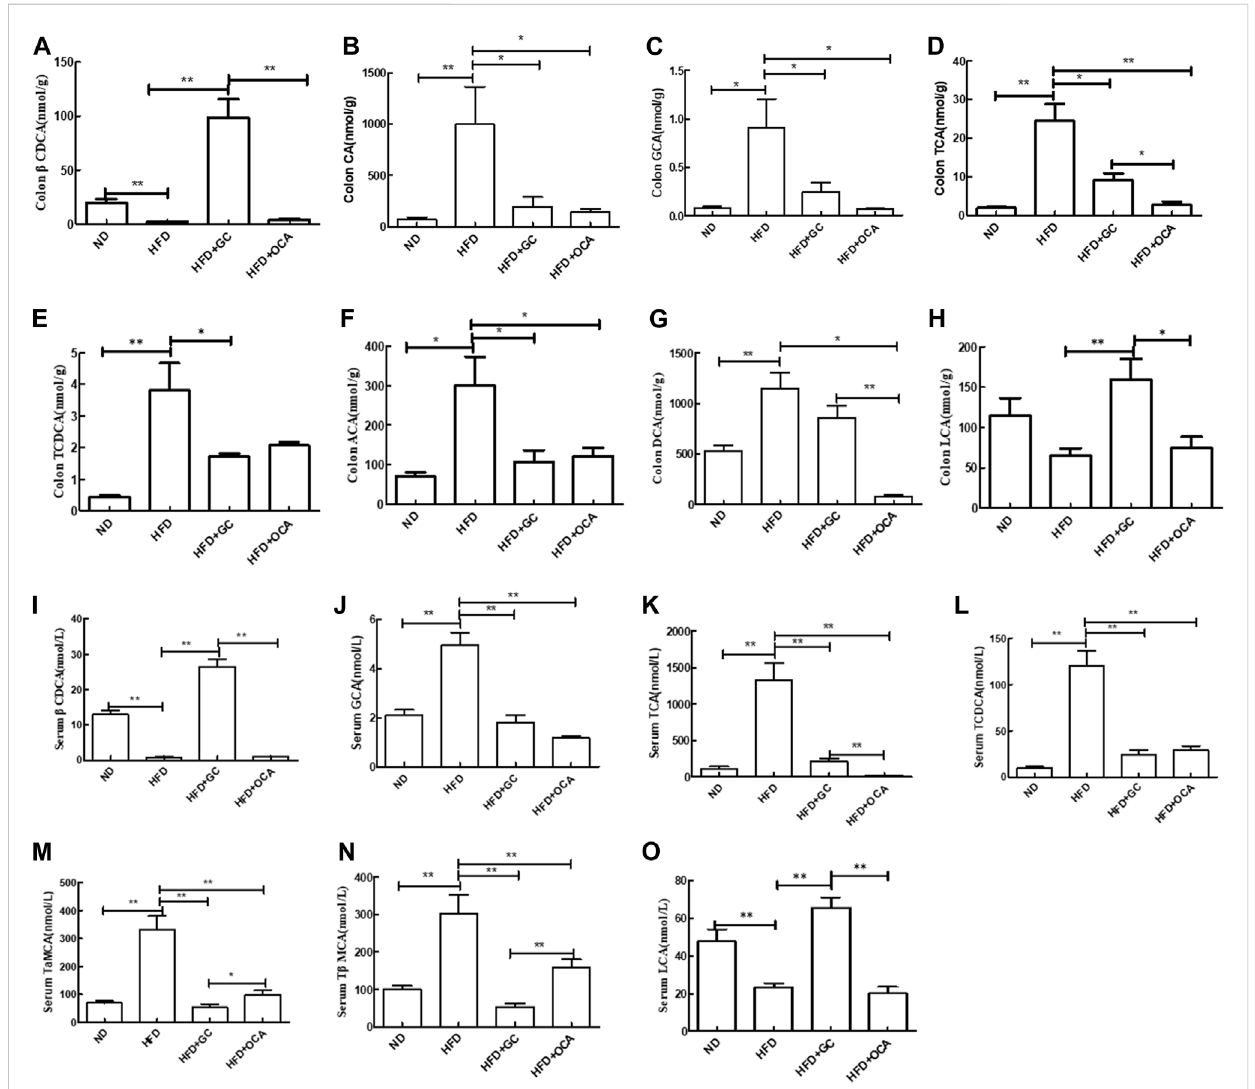
FIGURE 6 Changes in the bile acid levels in the colon contents and serum with intervention of GC or OCA in a mouse NAFLD model. (A) β CDCA in colon content. (B) CA in colon content. (C) GCA in colon content. (D) TCA in colon content. (E) TCDCA in colon content. (F) ACA in colon content. (G) DCA in coloncontent. (H) LCAincoloncontent. (I) Serum β CDCAlevel. (J) SerumGCAlevel. (K) SerumTCAlevel. (L) SerumTCDCAlevel. (M) SerumTaMCAlevel. (N) SerumT β MCAlevel. (O) SerumLCAlevel.Abbreviations:NAFLD,non-alcoholicfattyliverdisease;DCA,deoxycholicacid;GCA,glycocholicacid; β CDCA, 3 β -chenodeoxycholic acid; TCA, taurocholic acid; TCDCA, taurochenodeoxycholic acid; CA, cholic acid; ACA, allocholic acid; T β MCA, tauro β - muricholic acid; T α MCA, tauro α -muricholic acid; LCA, lithocholic acid. ND, normal diet; HFD, high-fat diet; GC, geniposide and chlorogenic acid combination treatment; OCA, obeticholic acid. * p < 0.05 and ** p < 0.01 ( n = 5 per